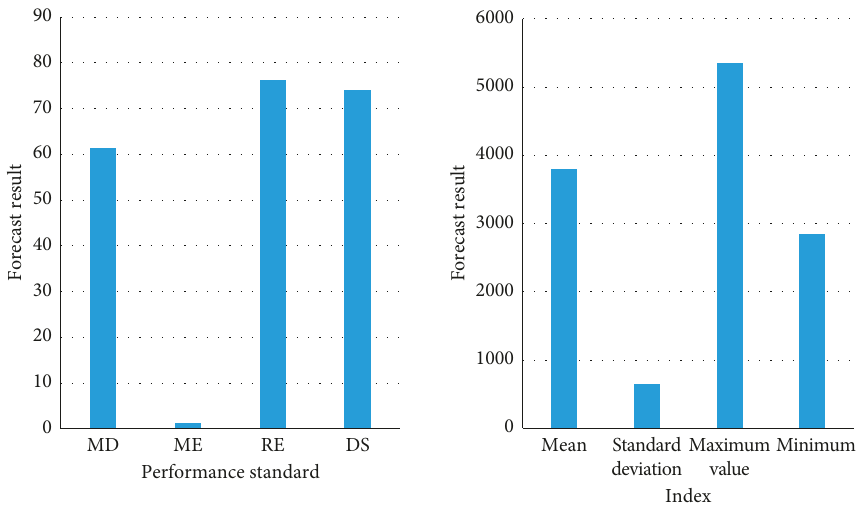
Figure 10: Data related to prediction